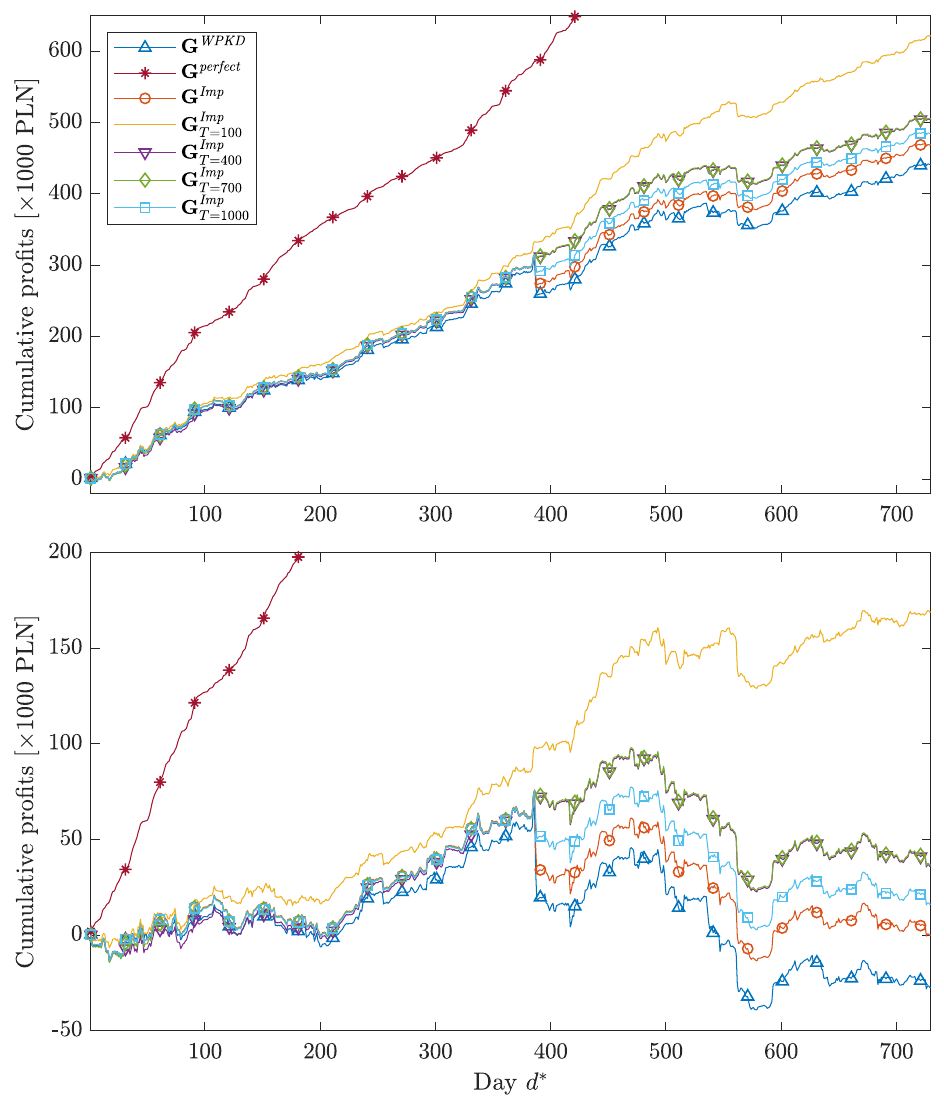
Figure 4. Comparison of cumulative profits for the different strategies considered and the whole two-year out-of-sample evaluation period. For all strategies, the commission is set to C = 4.25 PLN (upper panel) or C = 2.51 PLN (lower panel). The former is equivalent to a commission of ca. 1 EUR, the latter yields a total profit of zero for the G Imp strategy, see Table 1. The largest draw-down in profits for the unrestricted contract strategies occurred on 22.11.2018 ( d ∗ = 387), when wind generation was much lower than predicted and balancing prices spiked; the G Imp strategies were largely immunized by the tolerance T threshold. The second-largest draw-down—this time influencing all strategies—occurred on 16.05.2019 ( d ∗ = 562), when wind generation was overestimated, but balancing and day-ahead prices stayed similar, see the red triangles and blue circles in Figures 1 and